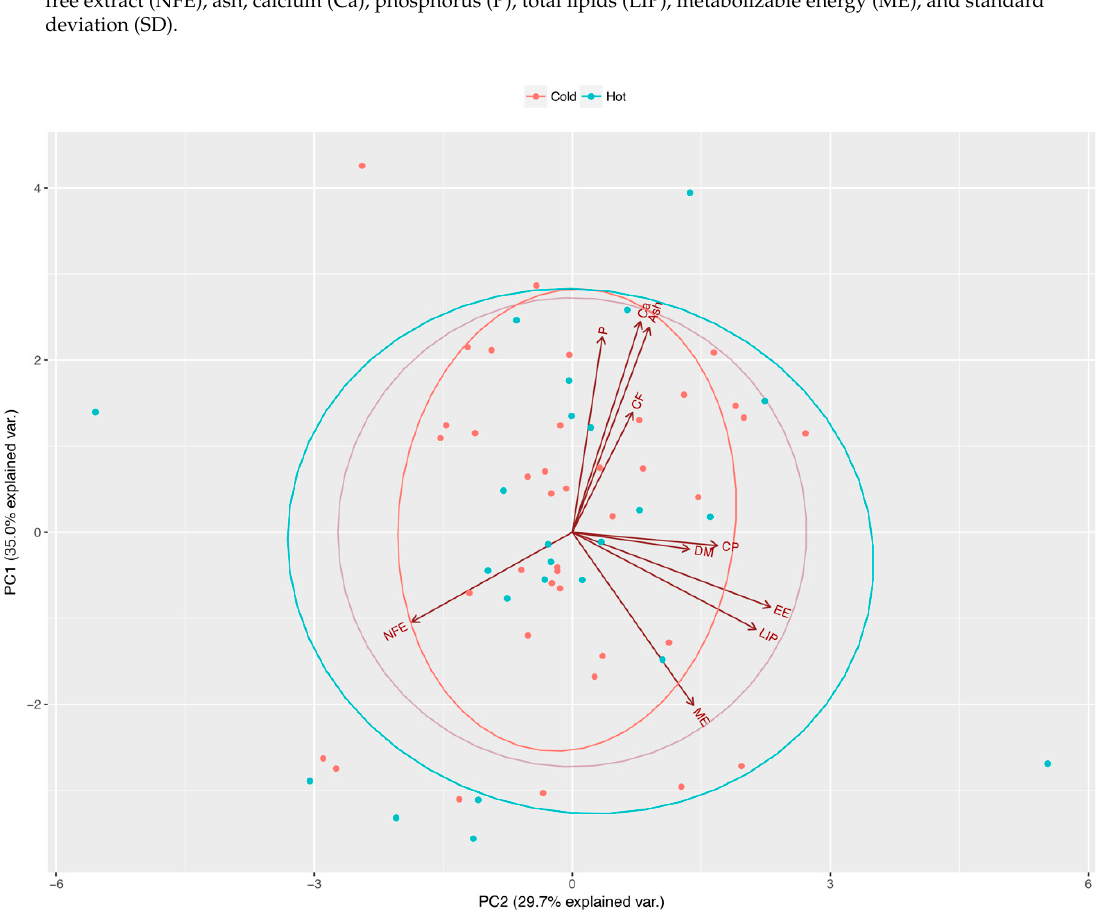
Figure 2. Distribution of food preference of kennel cats, on the first two principal components extracted from estimate contents of dry matter (DM), crude protein (CP), crude fiber (CF), ether extract (EE), nitrogen free extract (NFE), ash, calcium (Ca), phosphorus (P), total lipids (LIP), and metabolizable energy (ME) by proximal chemical analysis, acid hydrolysis, and calorimetric pump food decomposition. Space distribution of diet variables according to components 1 and 2, plotted as their eigenvectors and differentiated by climate season (cold and hot seasons ).